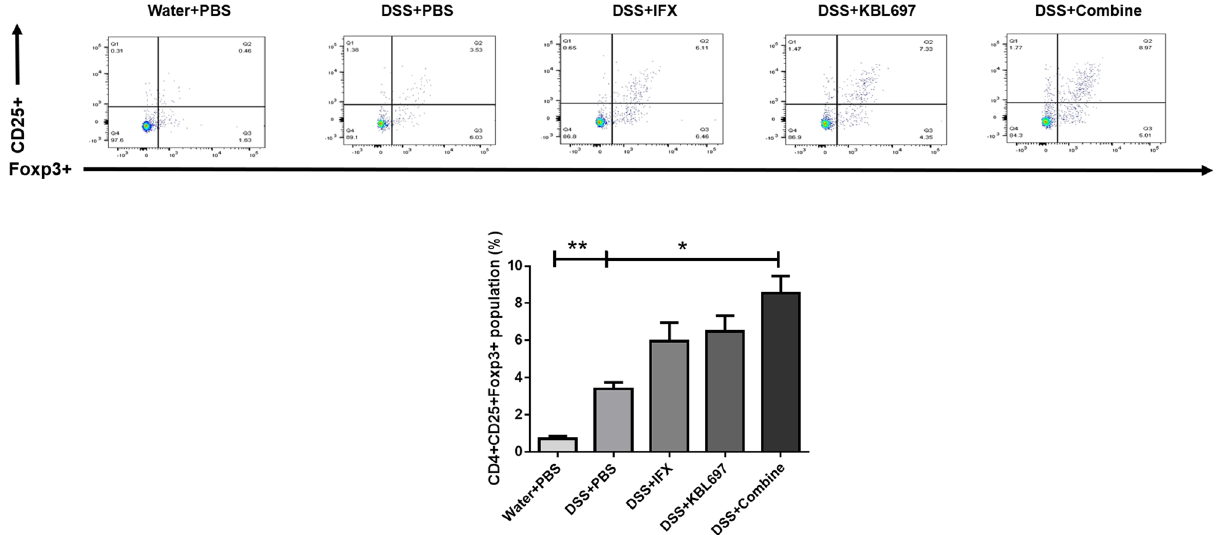
Figure 4. Effect of the different treatments on CD4 + CD25 + Foxp3 + Tregs. Statistical analysis was performed using one-way ANOVA with Dunnett’s post hoc test (* P < 0.05; ** P <